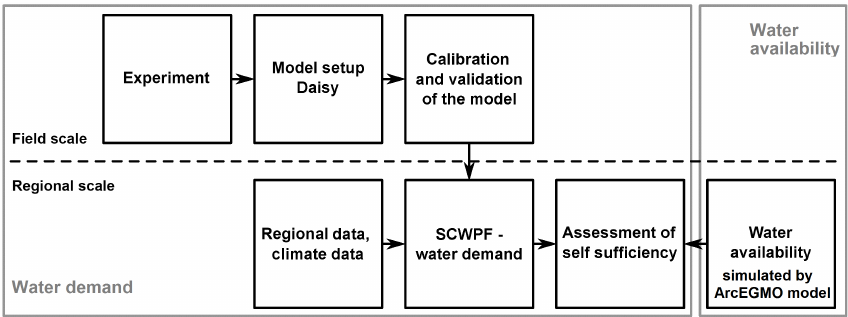
Figure 1. Work flow for estimating regional irrigation water demand from field scale simulations and regional water availability using the ArcEGMO model.